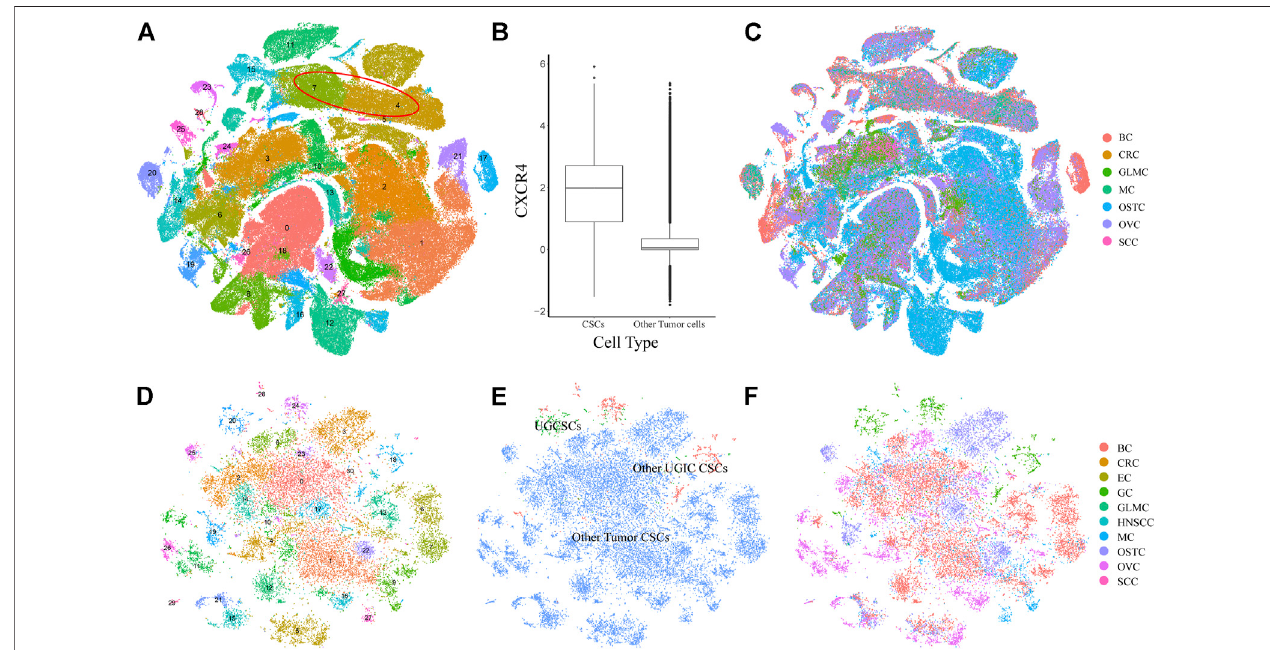
FIGURE 3 | Expression pro fi ling of 215,291 single cells in six cancer types. (A) t-SNE plot of 215,291 single cells in six cancer types, color-coded by 29 clusters. Clusters 4 and 7 are cancer stem cells, which are marked by a red circle. (B) Box plot shows the expression of the CSC marker gene CXCR4 . The x -axis represents the celltype.The y -axisrepresentsthelogvalueofthenormalized CXCR4expression. (C) t-SNEplotofothercancercells,color-codedbythecancertype. (D) t-SNEplotof all CSCs, color-coded by clusters. (E) t-SNE plot of all CSCs, color-coded by the CSC type. (F) t-SNE plot of all CSCs, color-coded by cancer types.